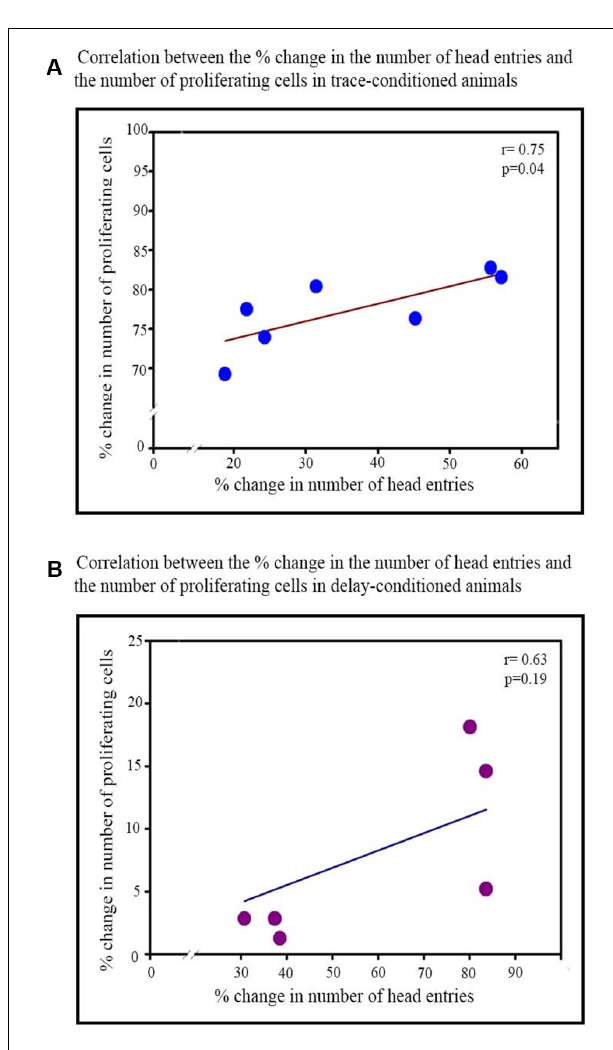
FIGURE 4 | Correlation between the percent increase in the number of head entries on testing day and percent increase in the number of proliferating cells in the trace- and delay-conditioned animals. (A) Trace-conditioned animals: the percent increase in the number of proliferating cells positively significantly correlated with the percent increase in the number of head entries on the testing day (* p < 0.05). (B) Delay-conditioned animals: the percent increase in the number of proliferating cells did not correlate significantly with the percent increase in the number of head entries on the testing